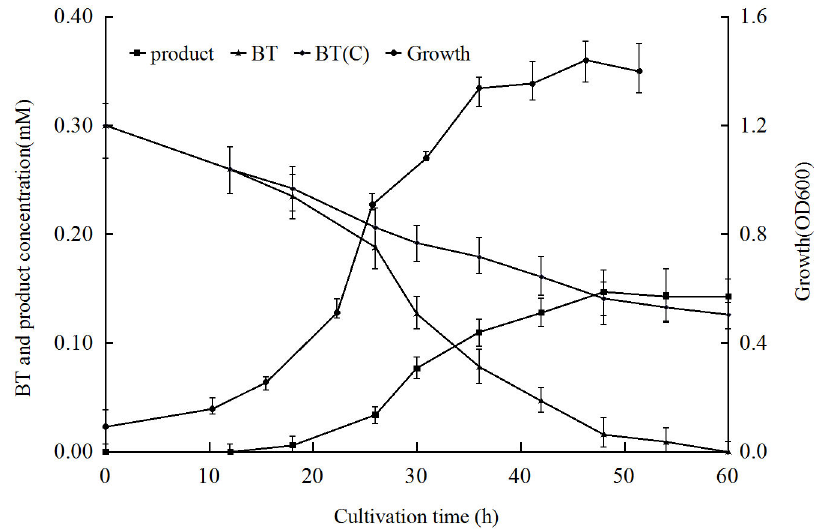
Figure 2. Biodesulfurization of BT during growth of G. terrae strain C-6. Strain C-6 was cultured in BSM BT as the sole source of sulfur. Black triangles, BT in the culture inoculating with strain C-6; black diamonds, BT in the culture without inoculating with strain C-6; black circles, bacterial growth; black squares, final product of BT biodesulfurization. doi: